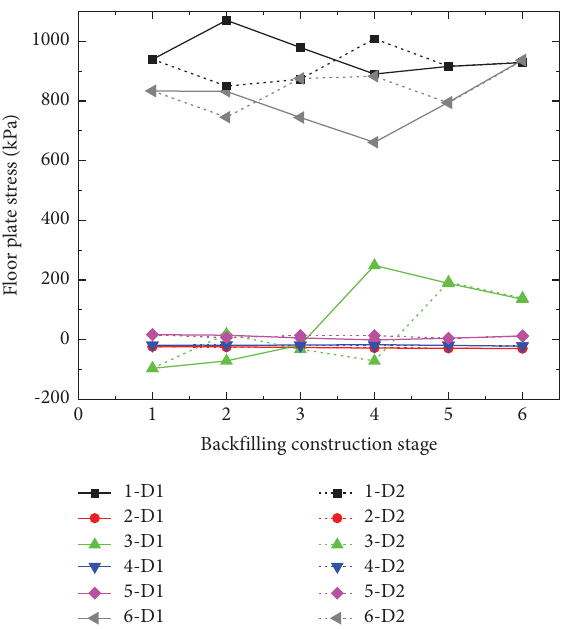
Figure 19: Te stress of the foor in the left-to-right backflling